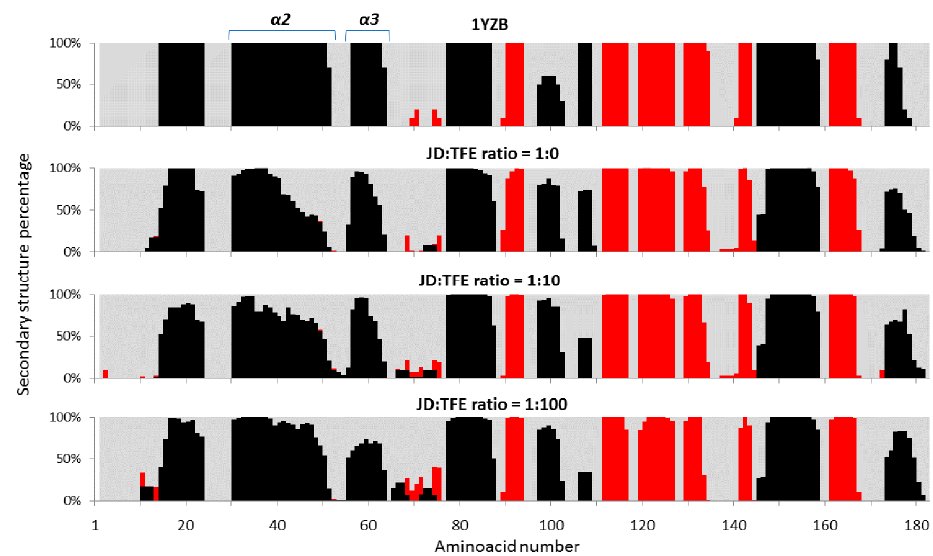
Figure 4. Secondary structure percentage, calculated over the last 20 ns of each MD trajectory at JD:TFE ratios of 1:0, 1:10, 1:100. MD data coming from the simulated trajectories are used as an ensemble for each concentration of TFE. The α -helix ( black ), beta-sheet ( red ) and unstructured coil ( light grey ) are represented.